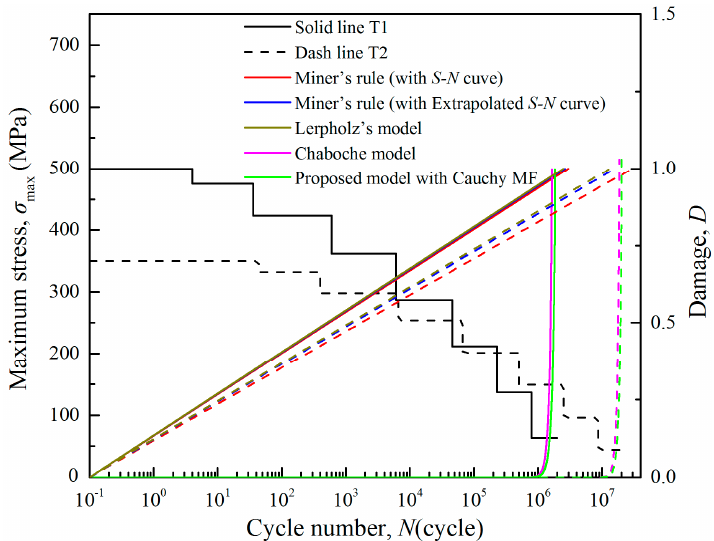
Figure 7. Comparisons in fatigue damage of 41Cr4 steel between the test data, the Wöhler model, the Chaboche model and the proposed